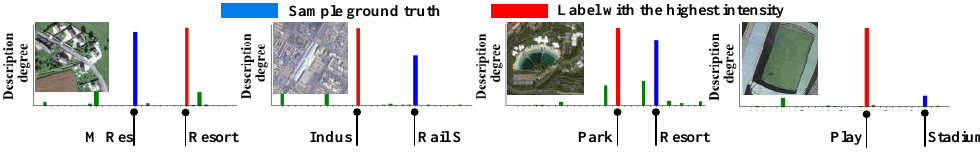
Figure 9. Distorted distributions produced by our method.